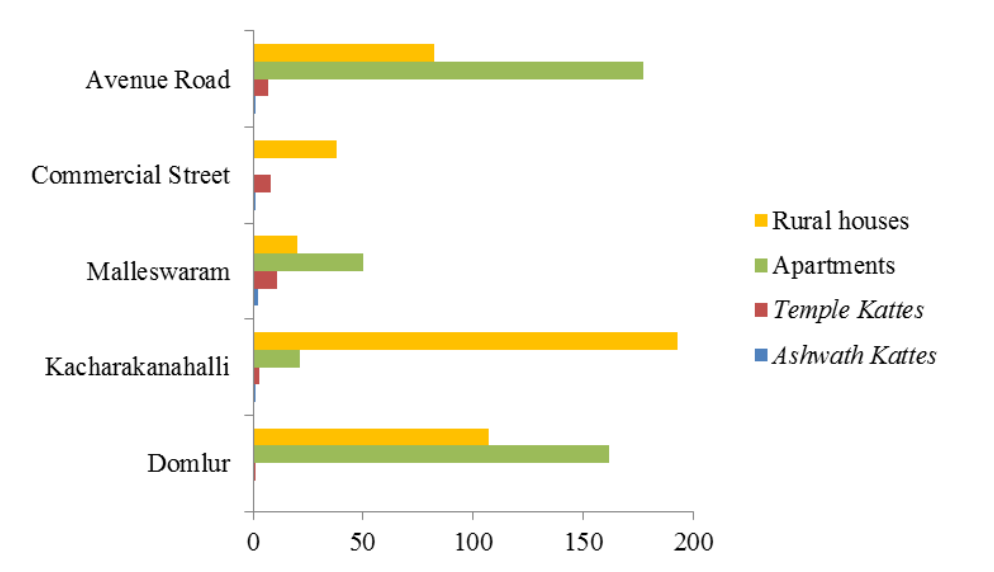
Figure 12. Distribution of indicators of rurality: number of rural houses, apartments, Temple Kattes and Ashwath Kattes in the five study locations in Bangalore, based on field surveys.